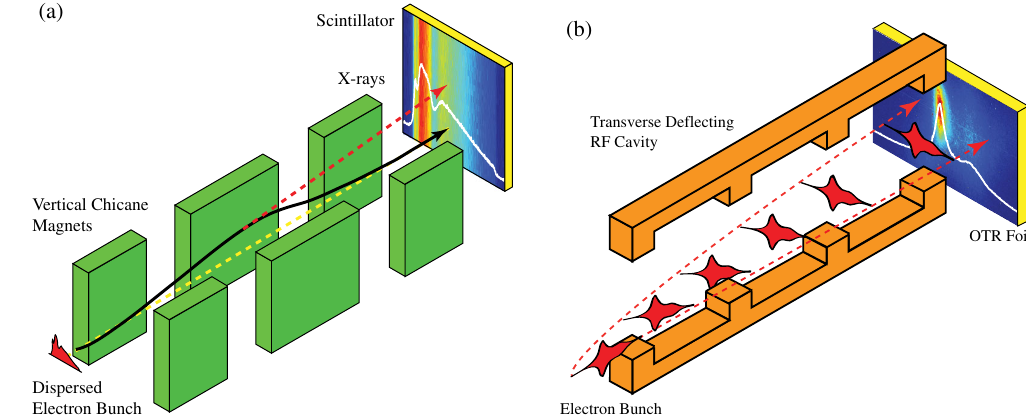
FIG. 1. The energy spectrum is recorded as the electron bunch passes through a series of magnets and radiates x rays. The intensity distribution of the x rays is correlated to the energy spectrum of the electron beam (a). This nondestructive measurement is available at all times, and used as the input to the ES scheme, which is then matched by adaptively tuning machine parameters in the simulation. For the TCAV measurement, the electron bunch is passed through a high frequency (11.4 GHz) rf cavity with a transverse mode, in which it is streaked and passes through a metallic foil (b). The intensity of the optical transition radiation (OTR) is proportional to the longitudinal charge density distribution. This high accuracy longitudinal bunch profile measurement is a destructive